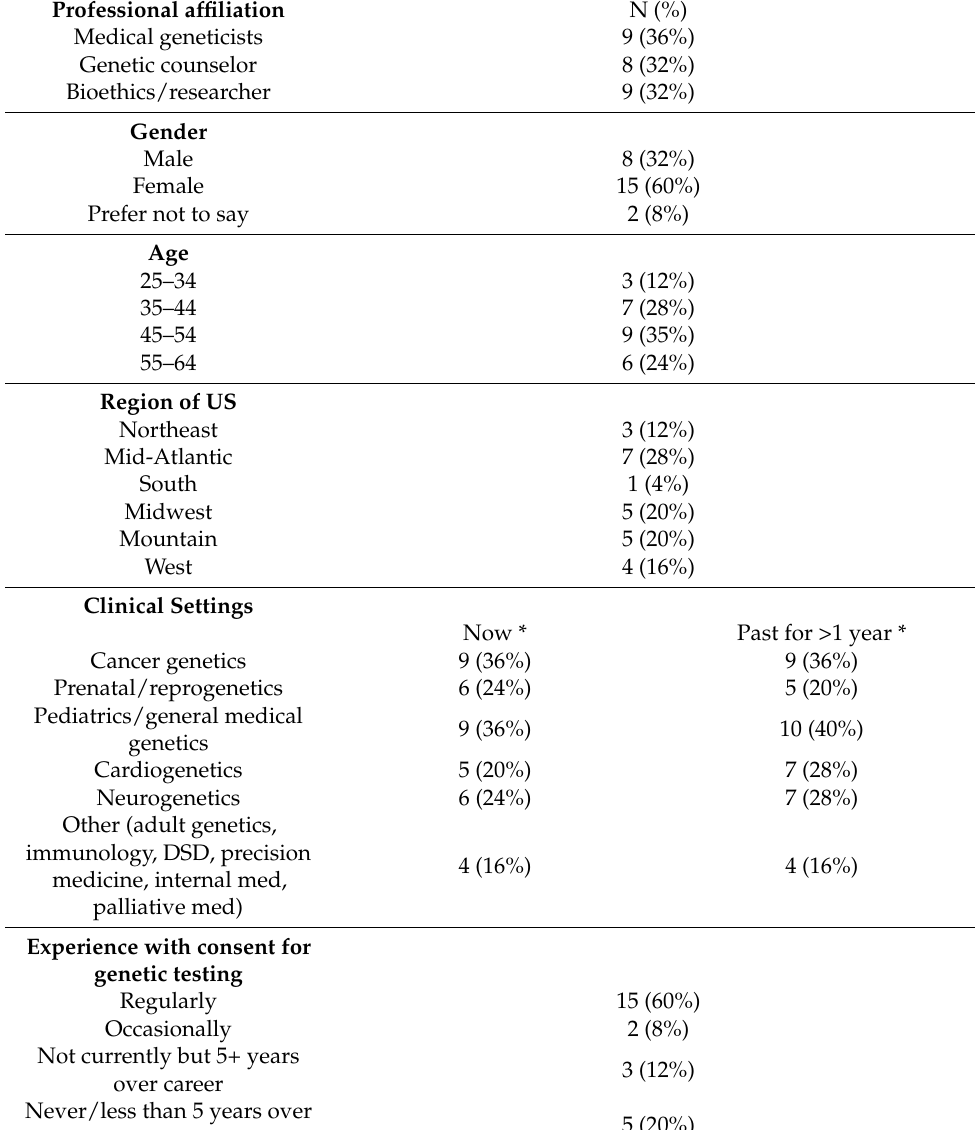
Table 1. Demographics of participants (N =